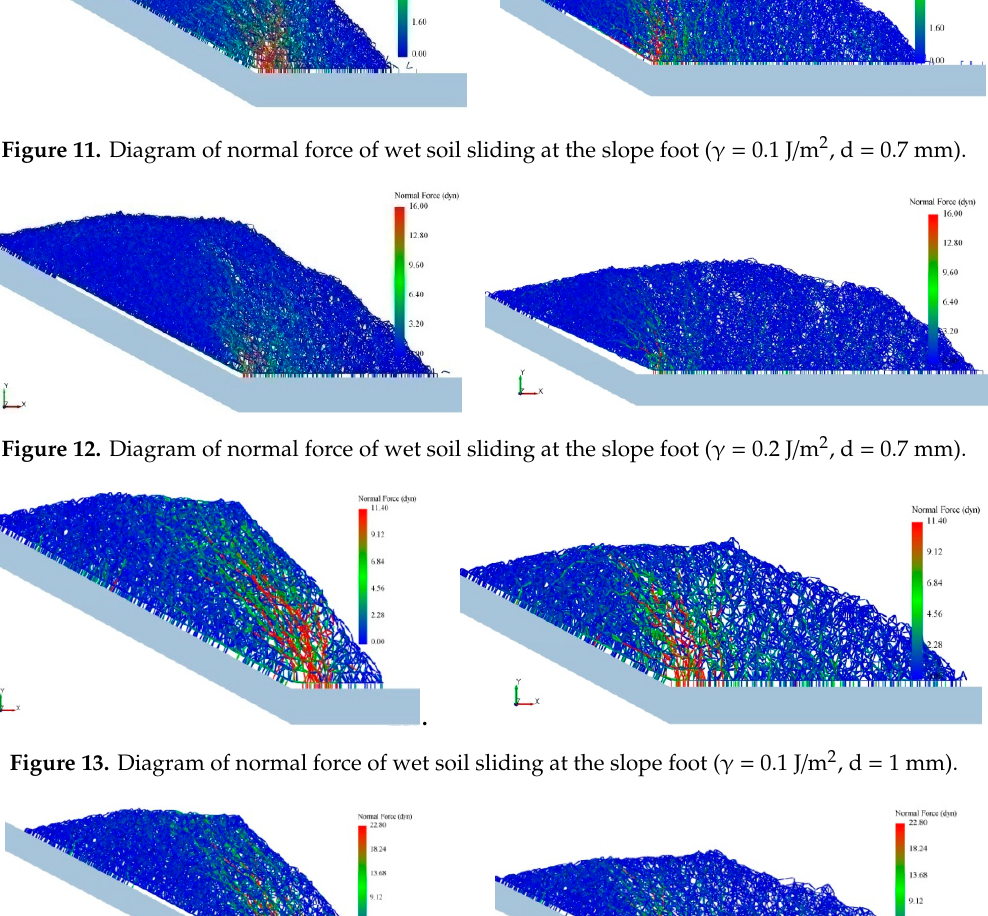
Figure 11. Diagram of normal force of wet soil sliding at the slope foot ( γ = 0.1 J/m 2 , d = 0.7 mm).